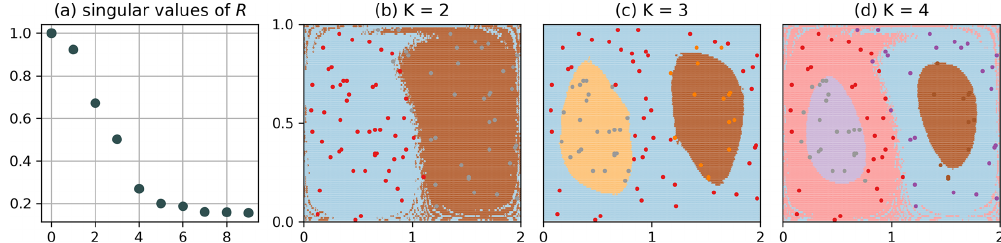
Figure 5. Clustering of Q for the incomplete data set, where 500 particles are retained and 80% of the data points subsequently deleted. (a) Singular values of R for the incomplete data set, with (cid:49)x = (cid:49)y = 0 . 4. (b–d) Points representing the initial position of those particles that have data at initial time. Background: result for the full trajectory with (cid:49)x = (cid:49)y = 0 . 04 (cf. Fig.